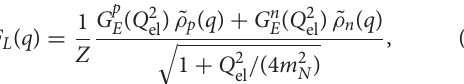
Figure 8 , the NV2+3-Ia potential predicts a smaller q value for the zero of the charge form factor in 12 C, hence a larger value for the charge radius, as confirmed by Figure 4